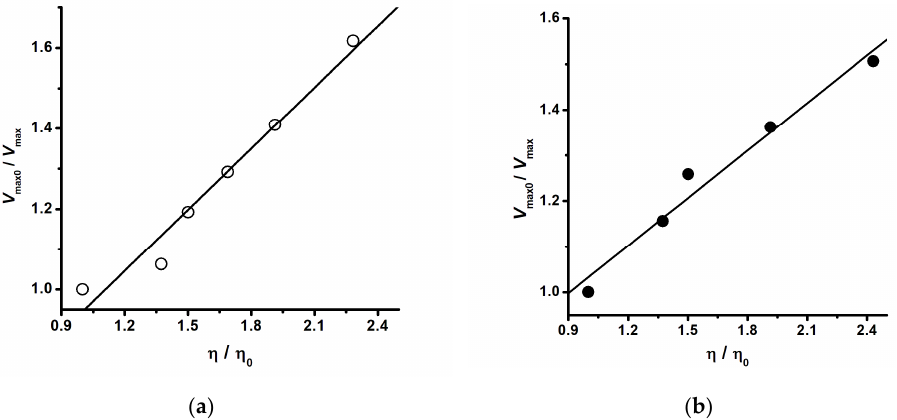
Figure 2. Dependence of enzyme catalysis (30 °C) on medium viscosity as described by Kramers´theory. ( a ) Viscosity dependence of V max of plasma membrane H + -ATPase from Kluyveromyces lactis . Adapted with permission from Sampedro et al. [31]. Copyright © 2020, American Society for Microbiology; ( b ) viscosity dependence of V max of lactate dehydrogenase (LDH) from rabbit muscle. Adapted with permission from Hernández-Meza and Sampedro [130]. Copyright © 2020, American Chemical Society.